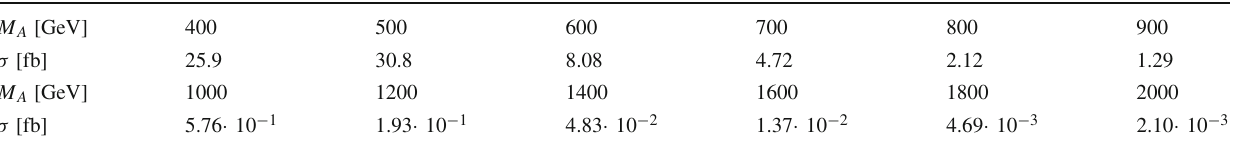
Table 5 Possible cross sections σ at 13 TeV for ggF → A → Z + h M A [GeV]